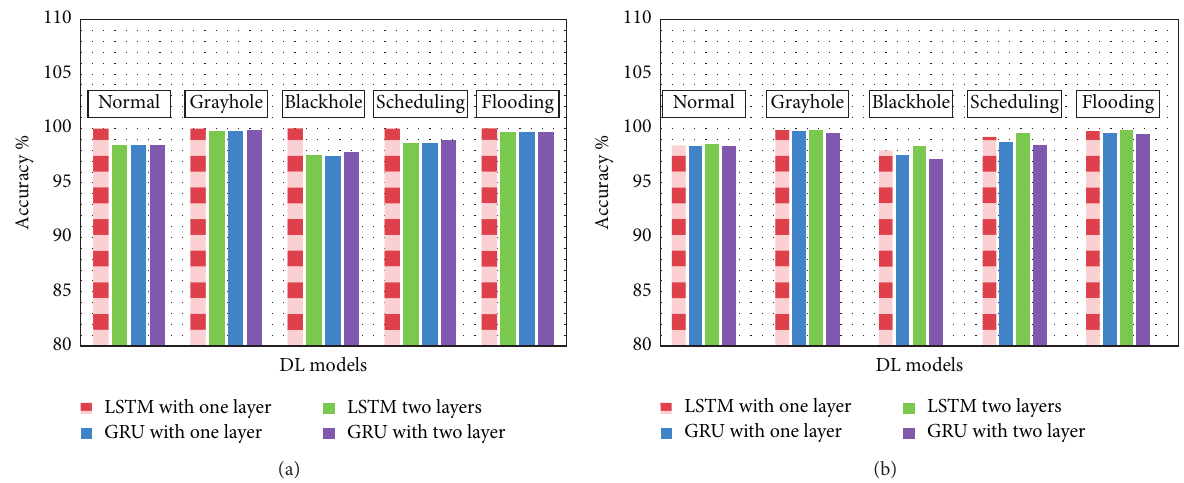
Figure 7: The results of deep learning cross-validation performance for WSN dataset: (a) accuracy using all features and (b) accuracy using selected